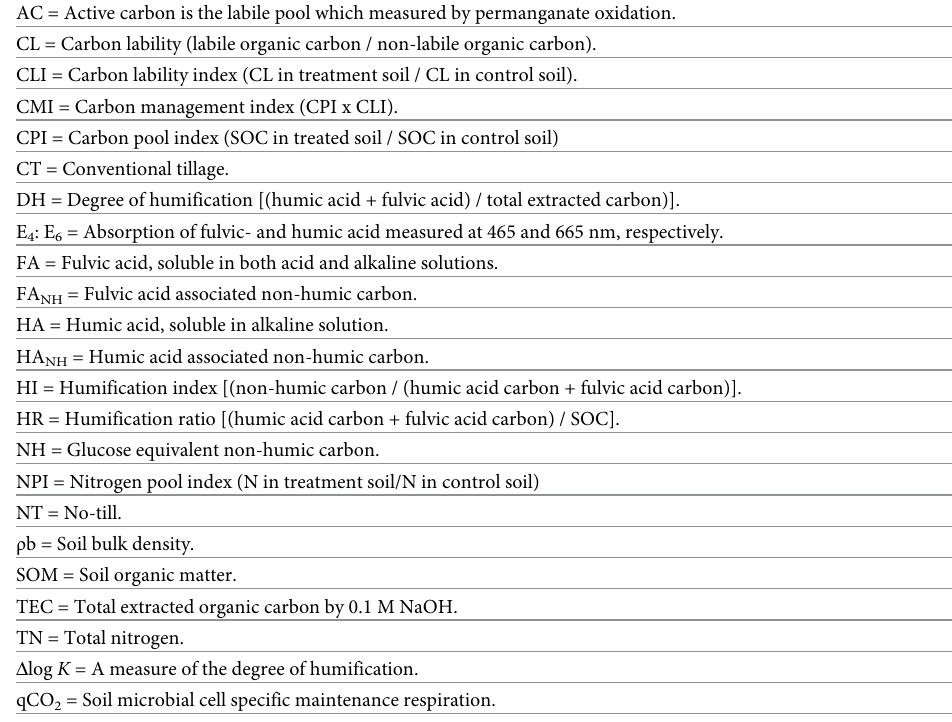
Table 1. List of abbreviations and